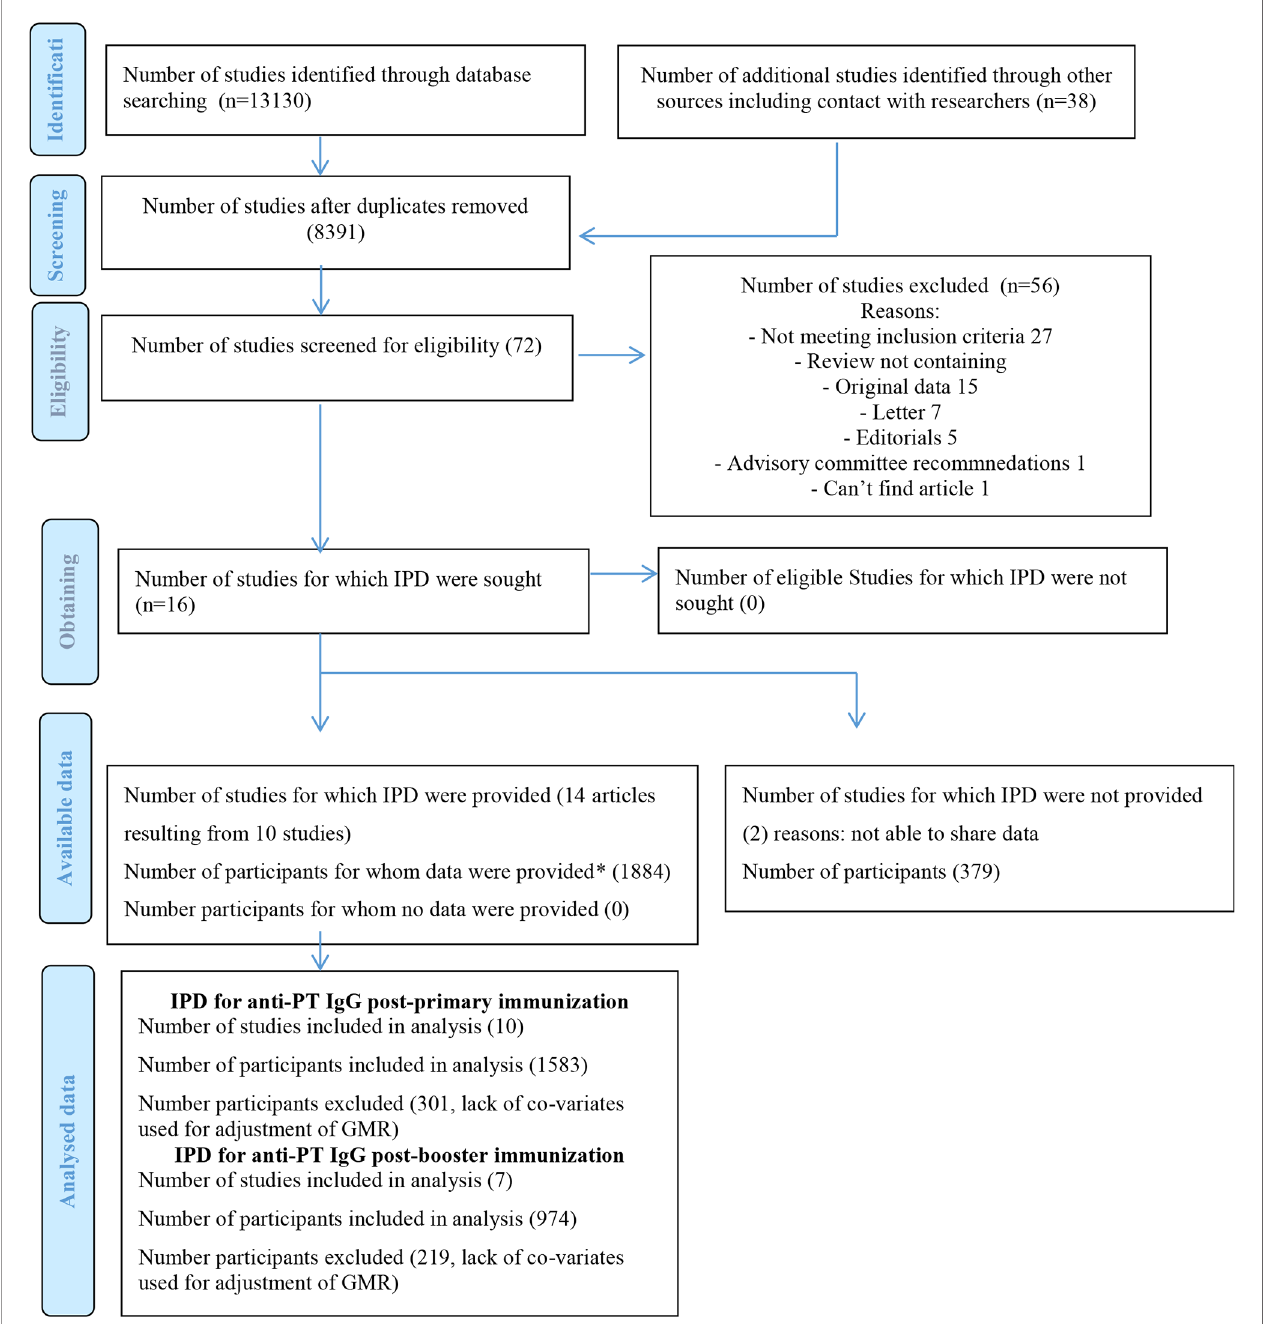
FIGURE 1 | PRISMA IPD Flow Diagram. IPD, individual-participant data; GMR, geometric mean ratio. * In order to con fi rm data integrity, the main analysis for each speci fi c study was recapitulated and compared to the published data. Adapted from: